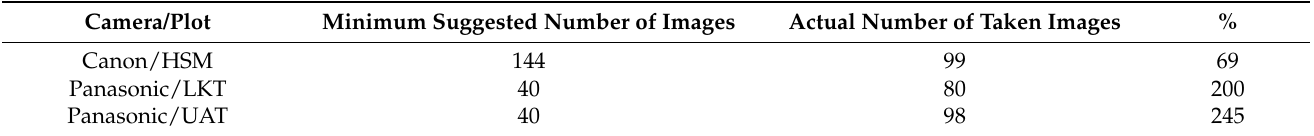
Table 4. Numbers of images suggested by the Agisoft manual and taken per plot. Camera/Plot